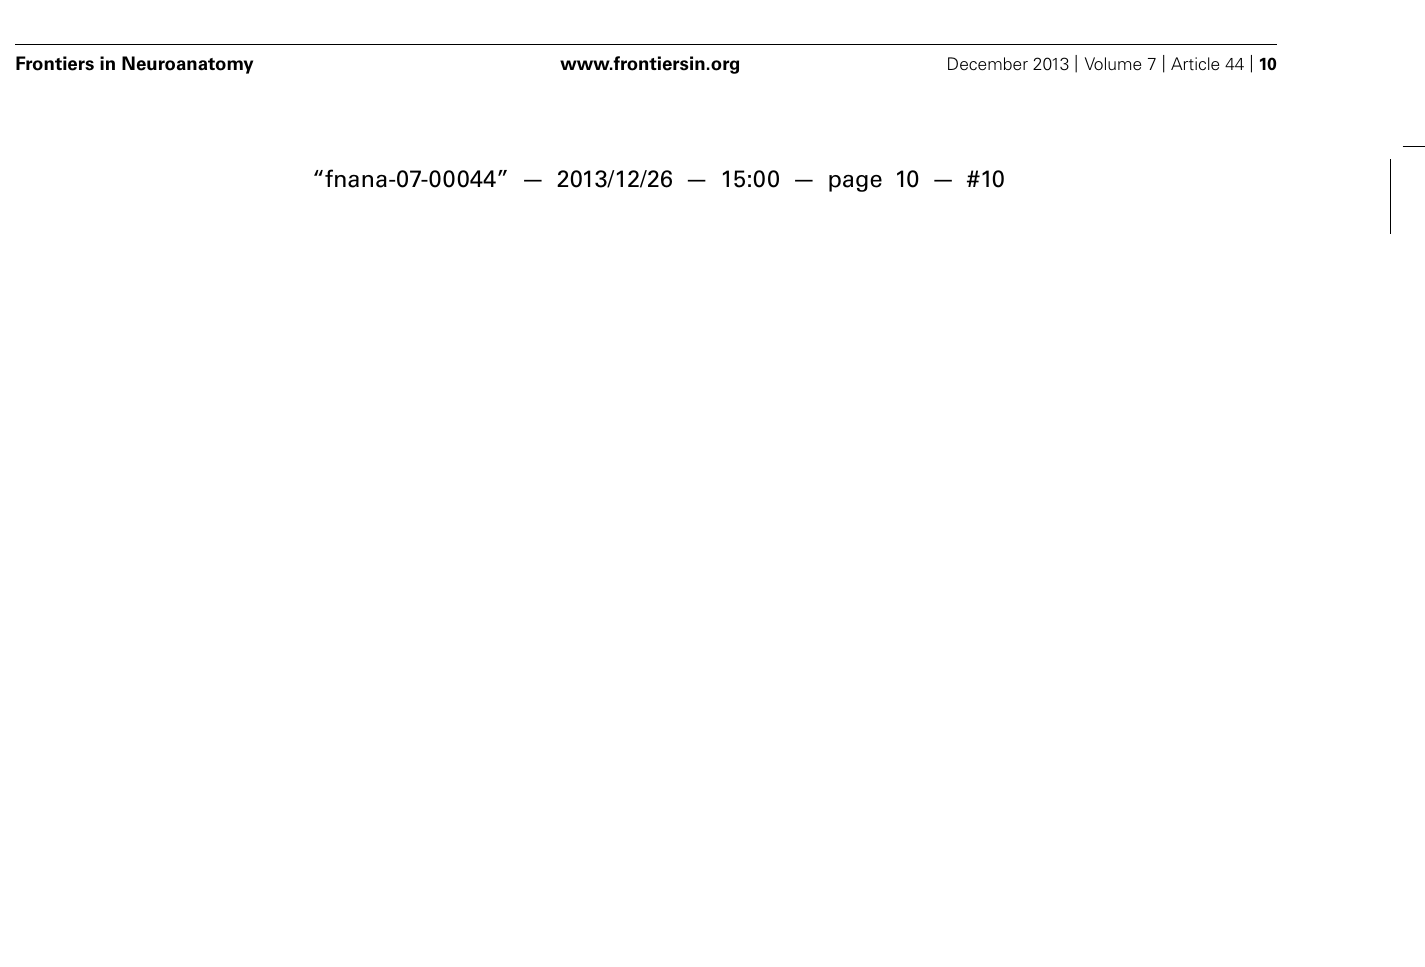
FIGURE 6 | Electron micrographs demonstrating the prevention of myelination or axon loss and inhibition of neuronal apoptosis by CNTF and C16 treatment. (A,B) Normal control group [ (A) , normal myelinated axons exhibited dark ring-shaped myelin sheaths surrounding the axon; (B) , normal nuclei of neuron with uncondensed chromatin]. (C–F) Vehicle- treated EAE rats at week 2 post-immunization.The myelin sheath displayed splitting, vacuoles (showed by arrow), and loose and fused changes, and axons were shrunken and dissolving (C) . Severe leaking out of the blood vessels and tissue emeda were detected in the extracellular space surrounding the vessels [showed by arrow in (D) ]. (E) Infiltrated leukocytes